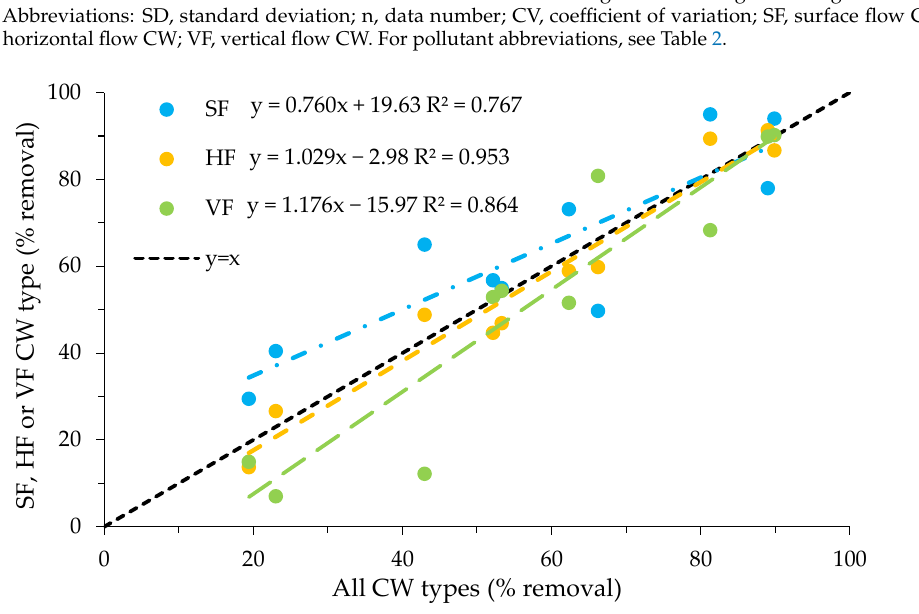
Figure 4. Correlations for EOC removal by each CW type versus EOC removal by all CW types (depicted values are from Table 3).